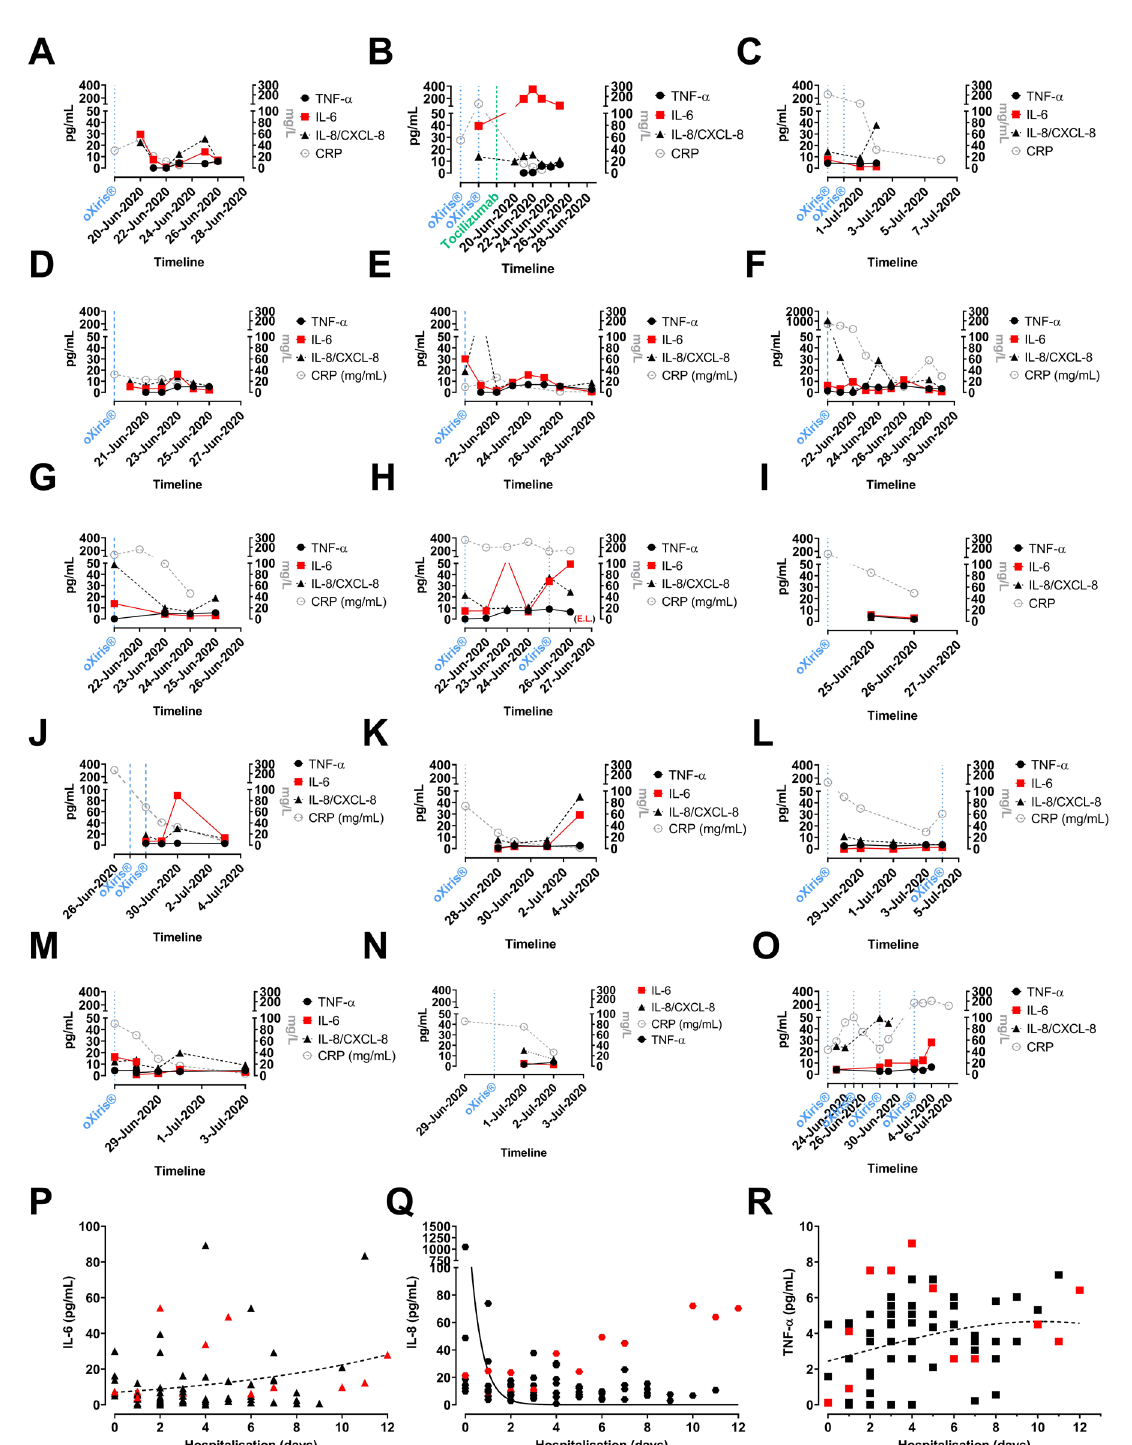
Fig. 6 - Inflammatory mediator analysis; systemic levels of interleukin (IL)-6, IL/chemokine (C-X-C motif) ligand 8 (CXCL-8), and tumour necrosis factor alpha (TNF-α). Individual cytokine profile (A – O) IL-6, IL-8, and TNF-α are plotted on the left y-axis (pg/mL), and C-reactive protein (CRP) is plotted on the right y-axis (mg/L). The start of oXiris® hemofiltration 24-cycle is shown on the x-axis. One patient (Panel B) also received Tocilizumab (= anti-IL-6 receptor mAb). Cytokine data are plotted on the left y-axis; CRP (grey checkered line) values are plotted on the right y-axis. Panels (P, Q, and R) show combined data during hospitalisation for IL-6, IL-8, and TNF-α. The coloured (red #1) (purple #2) symbols show the values for the two mortality